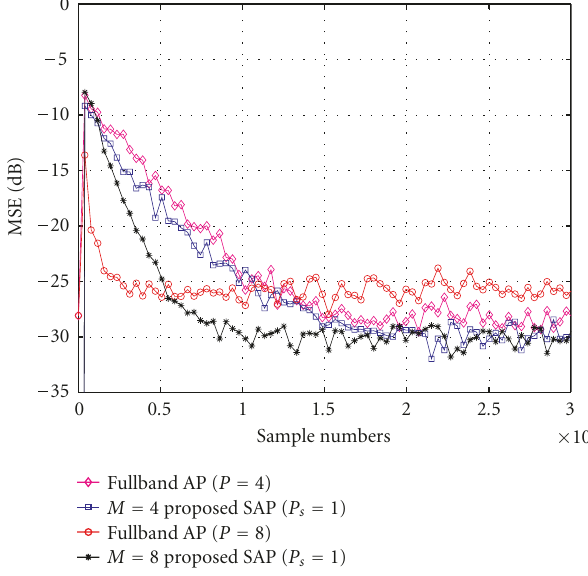
Figure 14: Comparison of MSE curves of each algorithm for AR(4) ( N = 512, μ = 1, SNR = 30